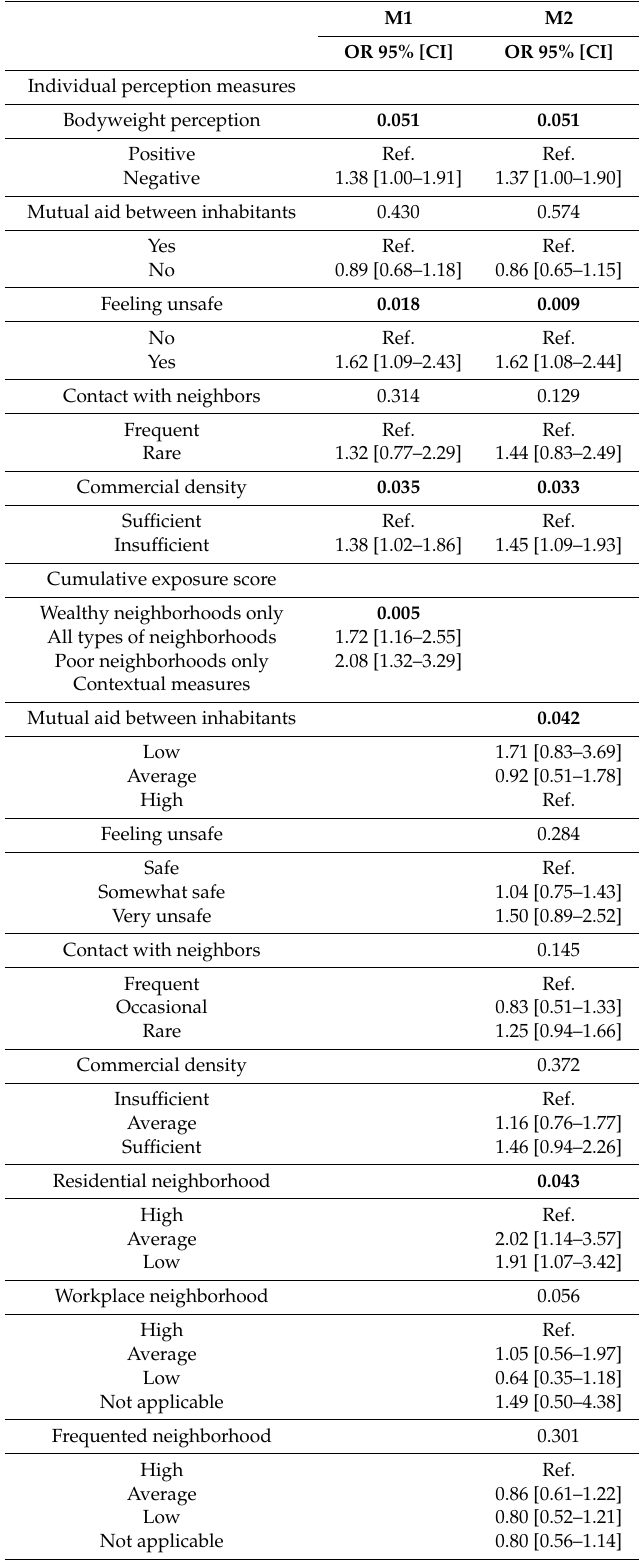
Table 3. Multivariate analysis of the associations between individual perceptions measures, cumulative exposure score, contextual neighborhood characteristics and depression, SIRS,